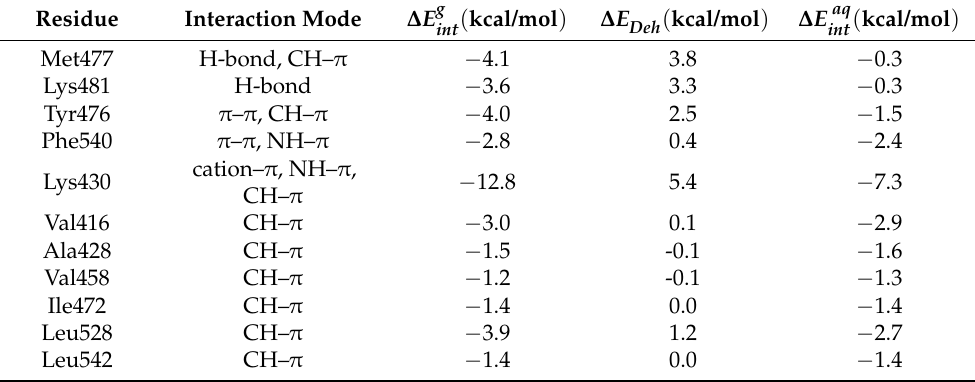
Table 4. Intermolecular interaction energies between ibrutinib and its interacting residues from tyrosine kinase